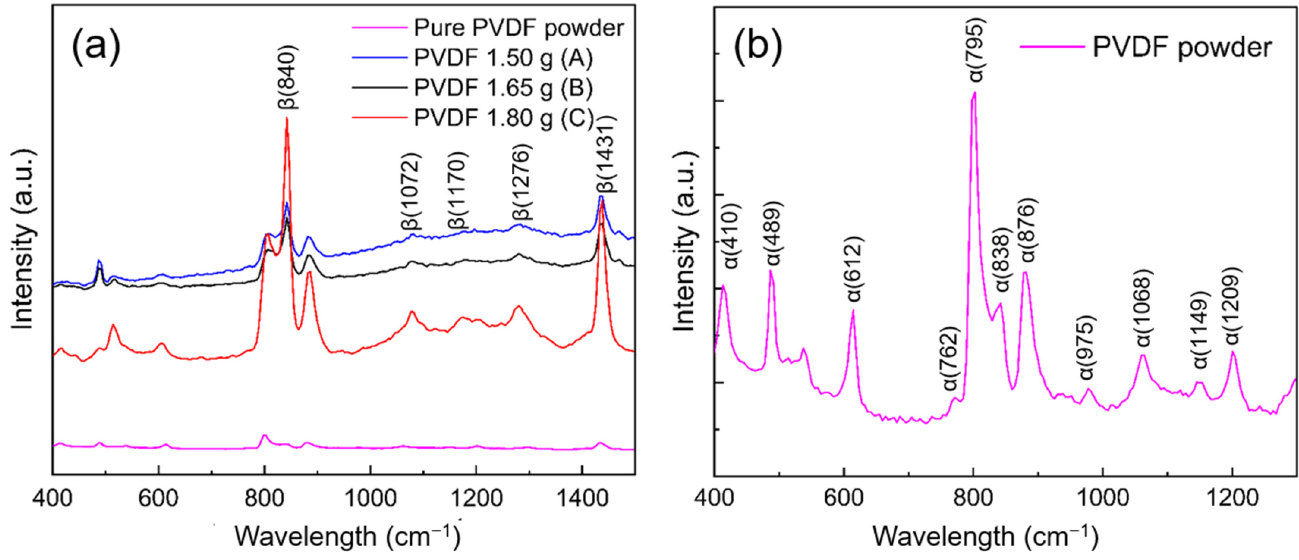
Figure 6. ( a ) Raman spectra of electrospun PVDF nanofibers including samples A, B and C and ( b ) pure PVDF powder.